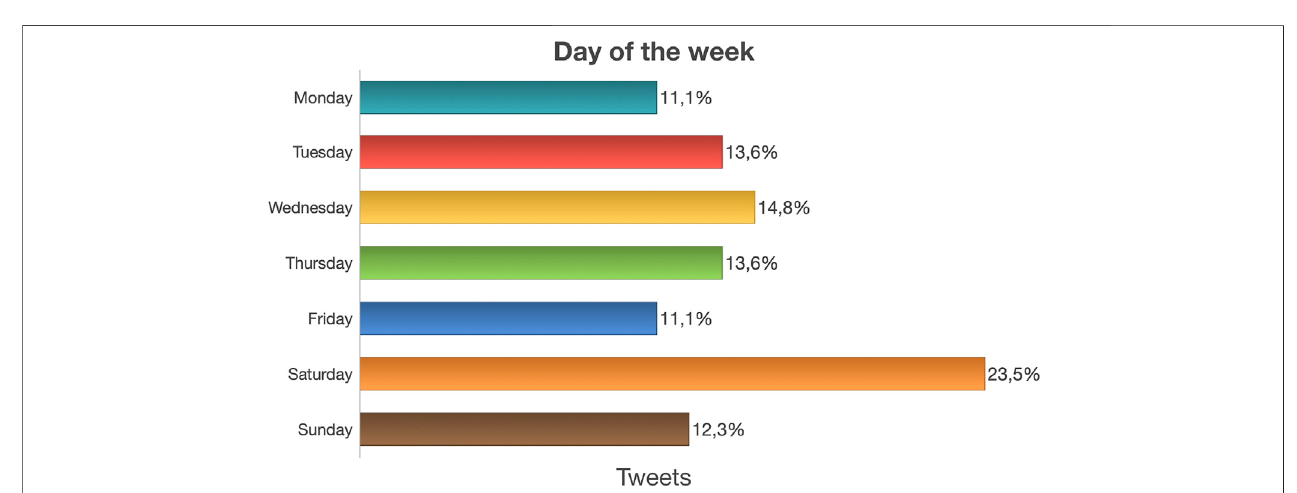
FIGURE 8 | Days of the week of the ABCA